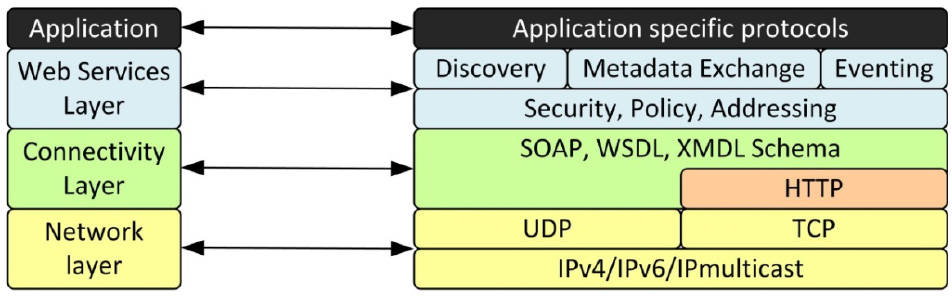
Figure 8. IEC 61850 and DPWS components, as described in [26].